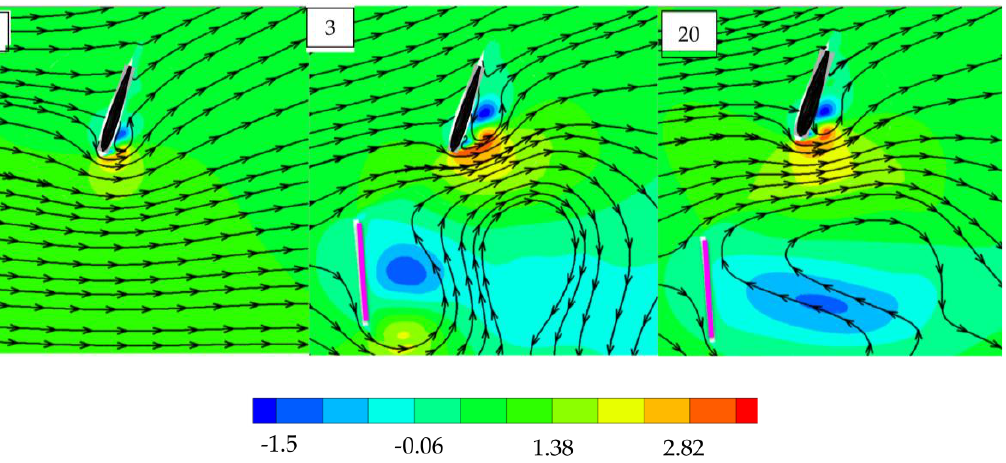
Figure 16. A comparison of the streamwise velocity and streamlines of a hydrofoil with an upstream deflector at different deflector – hydrofoil spacings J * .